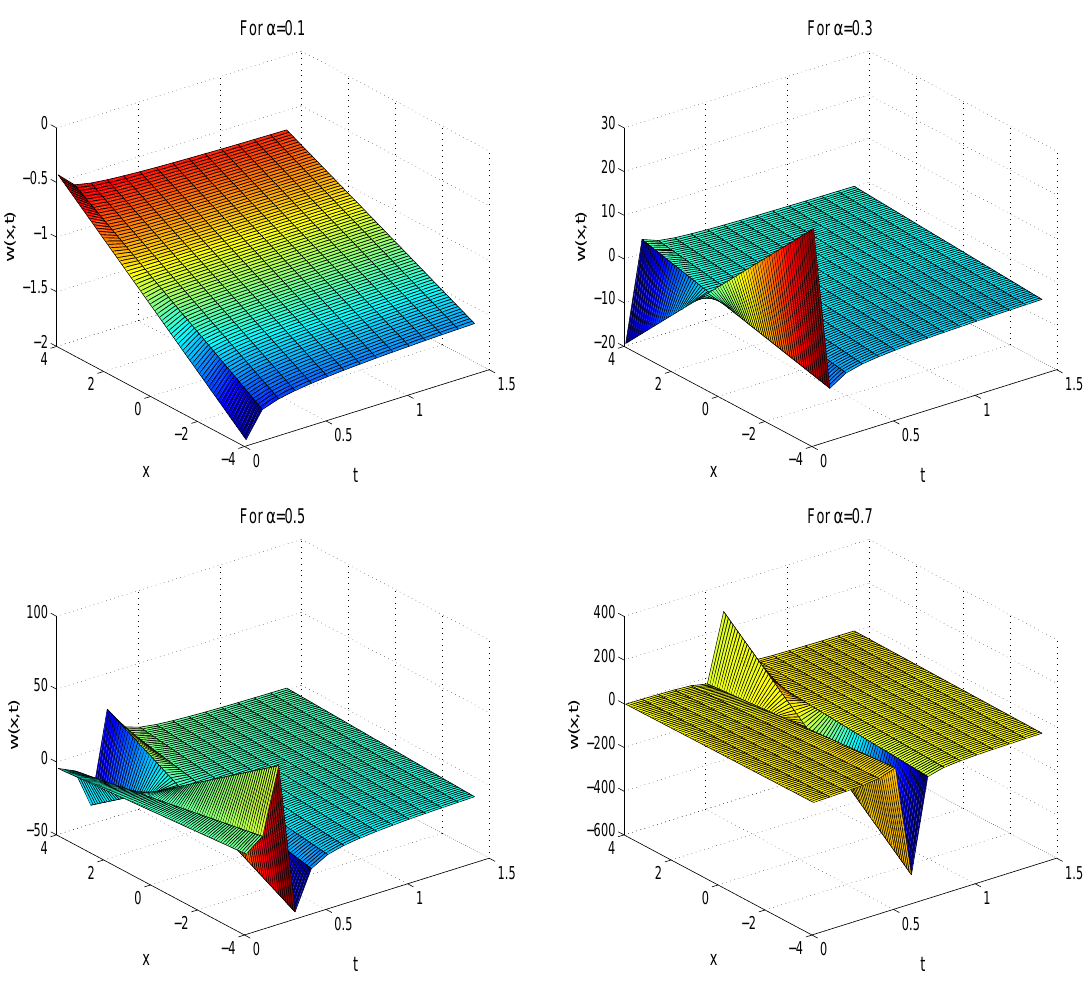
Figure 1. Effects on solution w ( x , t ) for different values of α .